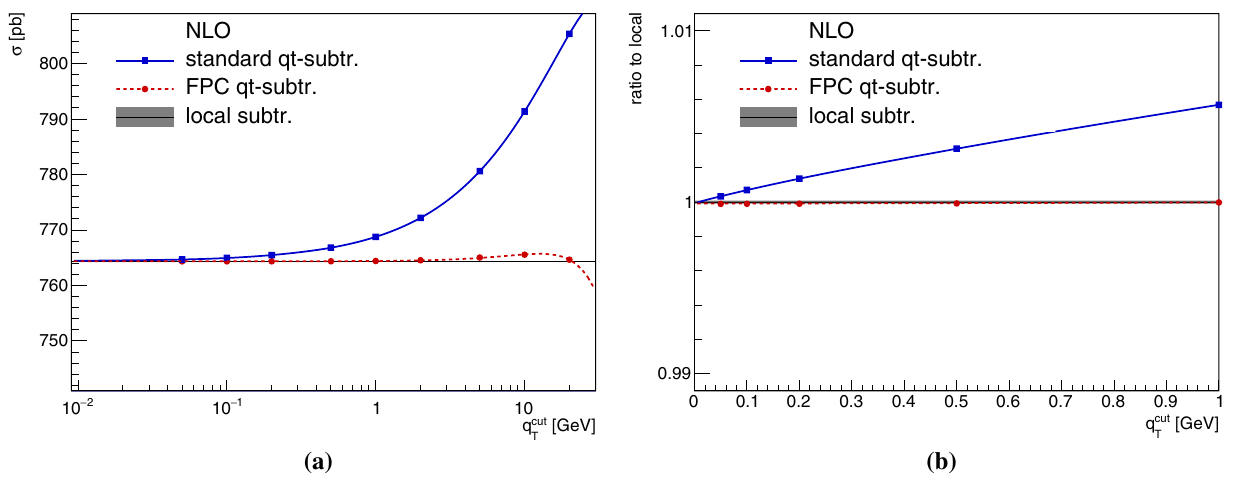
Fig. 1 Fiducial cross section for the production of l + l − pairs from √ Z /γ ∗ decay at the LHC ( s = 13 TeV). NLO results with the q T subtraction method (blue squared points) and q T subtraction method